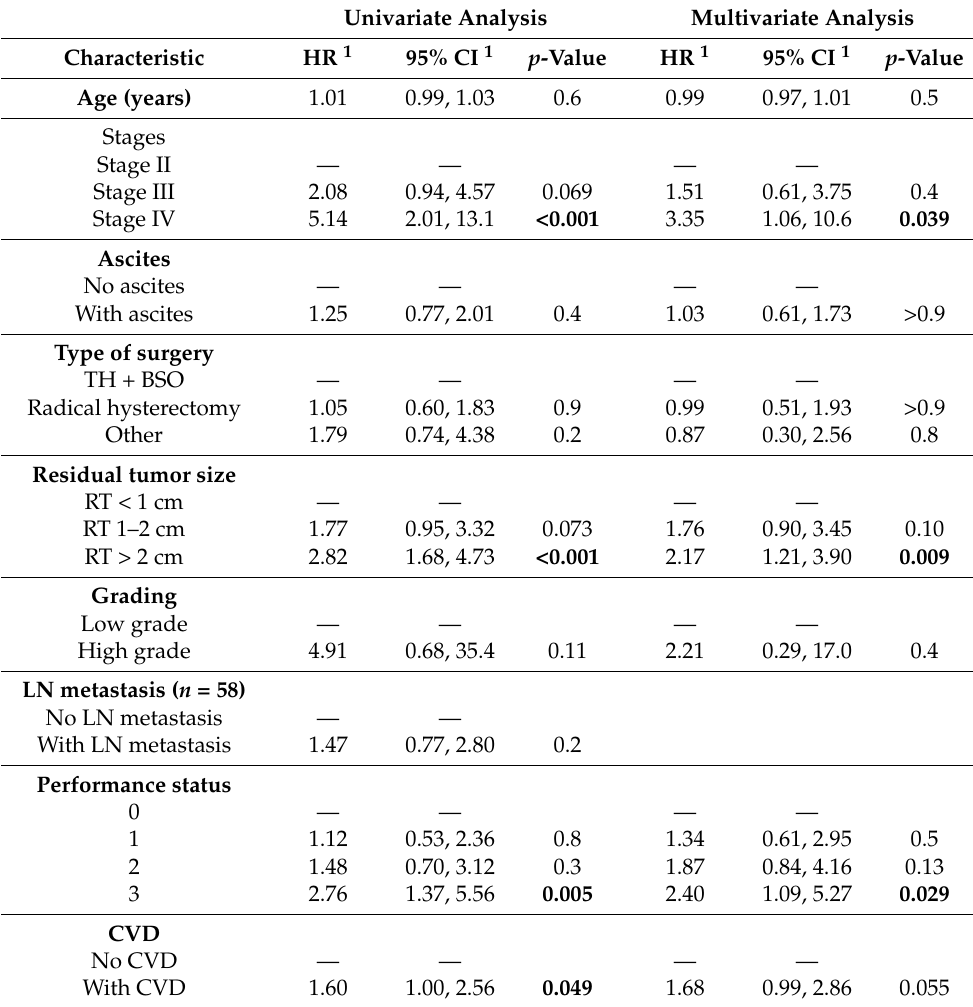
Table 3. Univariate and multivariate Cox regression analysis of overall survival. Univariate Analysis Multivariate